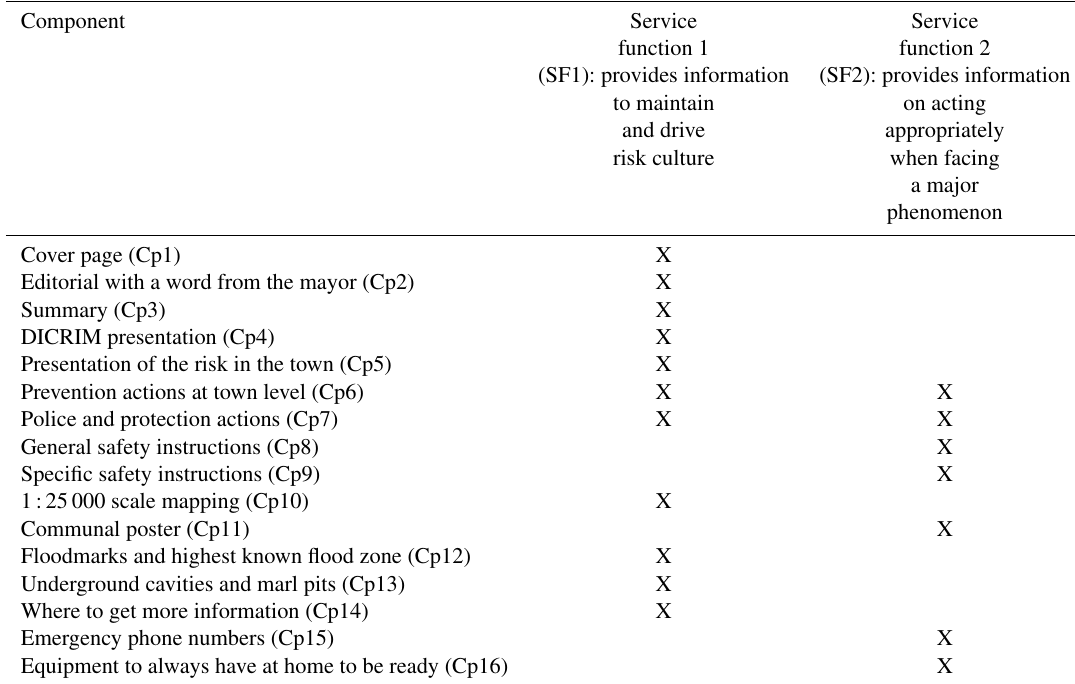
Table 3. Components and links with service functions. Component Service Service function 1 function 2